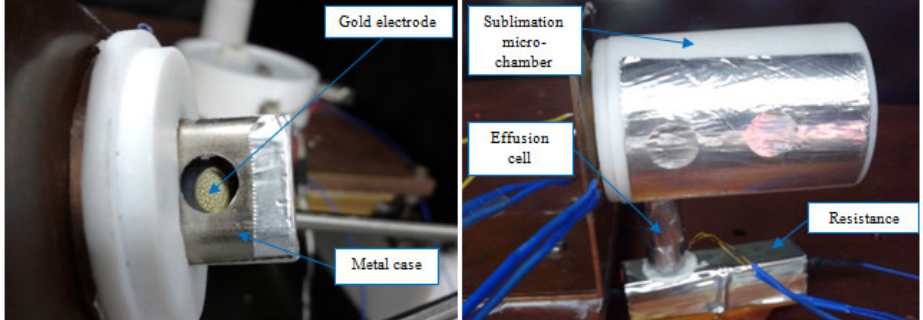
Figure 2. Pictures of the experimental set-up. Left: PCM inserted in the metal case. VOC molecules deposited on the PCM’s electrode are visible and correspond to the white spots on the crystal area. Right: the sublimation micro-chamber containing the PCM and the outgassing material. It is made of insulating material (Teflon) in order to limit sublimation and thermal dispersion. The contacts are instead made of grease vacuum.